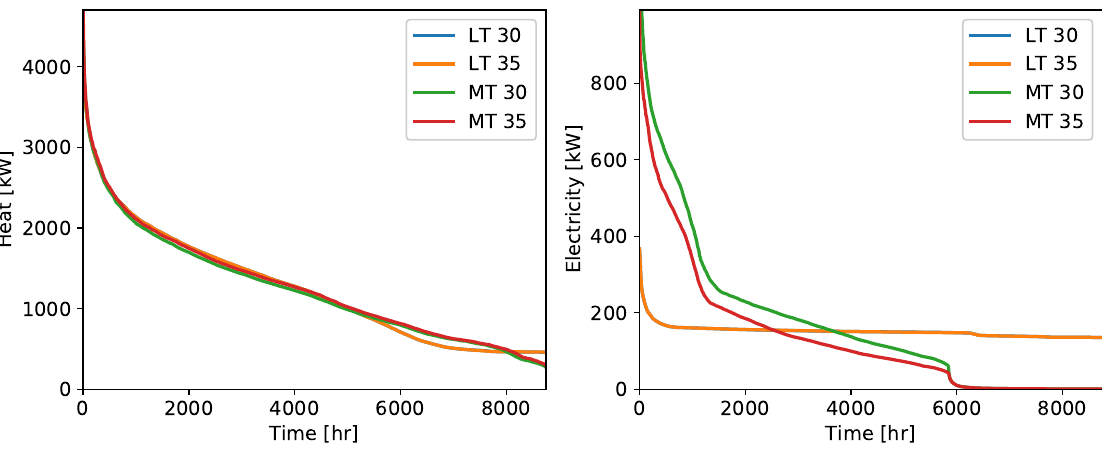
Figure 6. The duration curves for heat ( left ) and electricity ( right ) for the four simulated cases. The duration curve for heat includes the supply by both waste heat and DH; and the curve for electricity includes the use to both compressors and